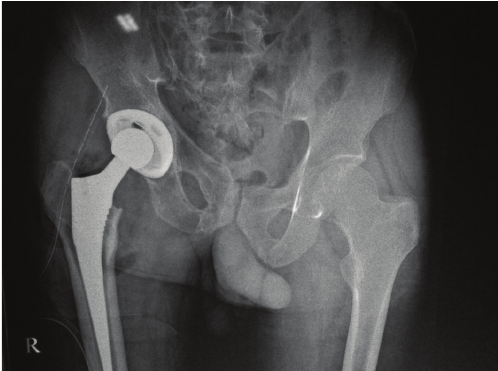
F 4: Postoperative radiograph.